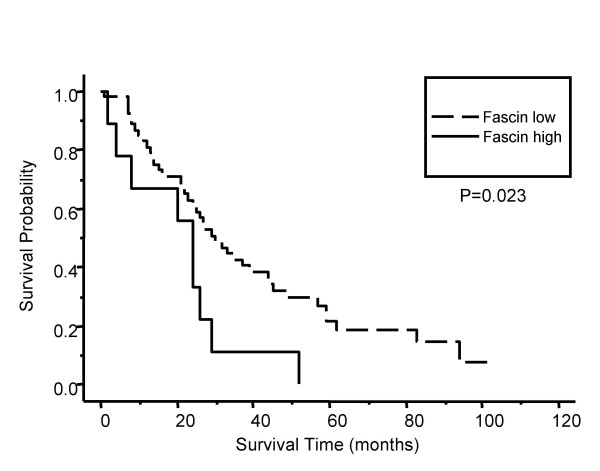
High fascin expression correlates with a clinically aggressive tumor phenotype. The Kaplan-Meier survival curves show that stage III and IV patients with highly fascin-positive adenocarcinomas had decreased survival compared to patients with fascin-low or -negative tumors (significant at p = 0.023).